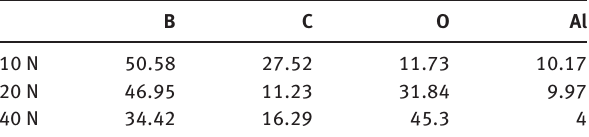
Table 3: EDX analysis of S1 worn surfaces.